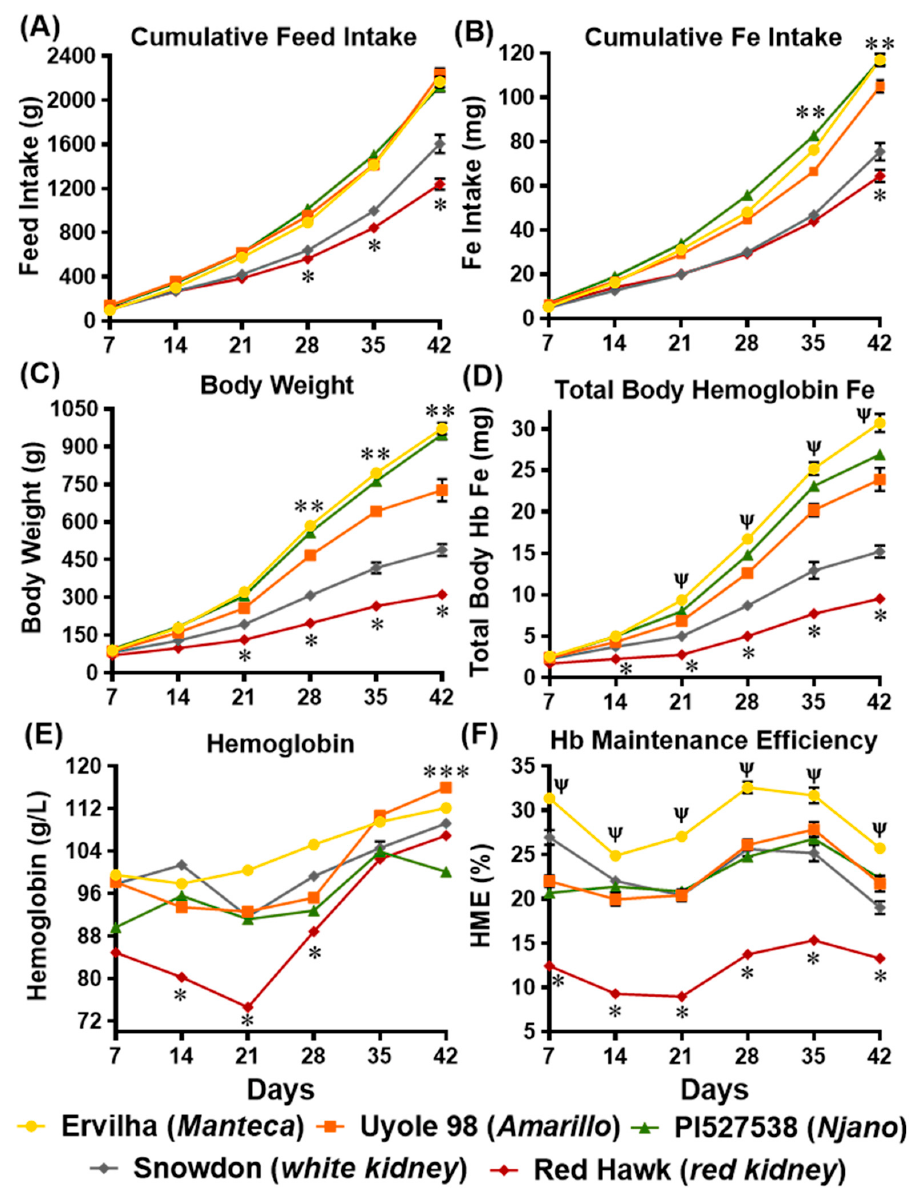
Figure 2. Cumulative feed intake ( A ), Fe intake ( B ), body weight ( C ), total body hemoglobin Fe ( D ), hemoglobin concentration ( E ) and hemoglobin maintenance e ffi ciency (HME); ( F ) during